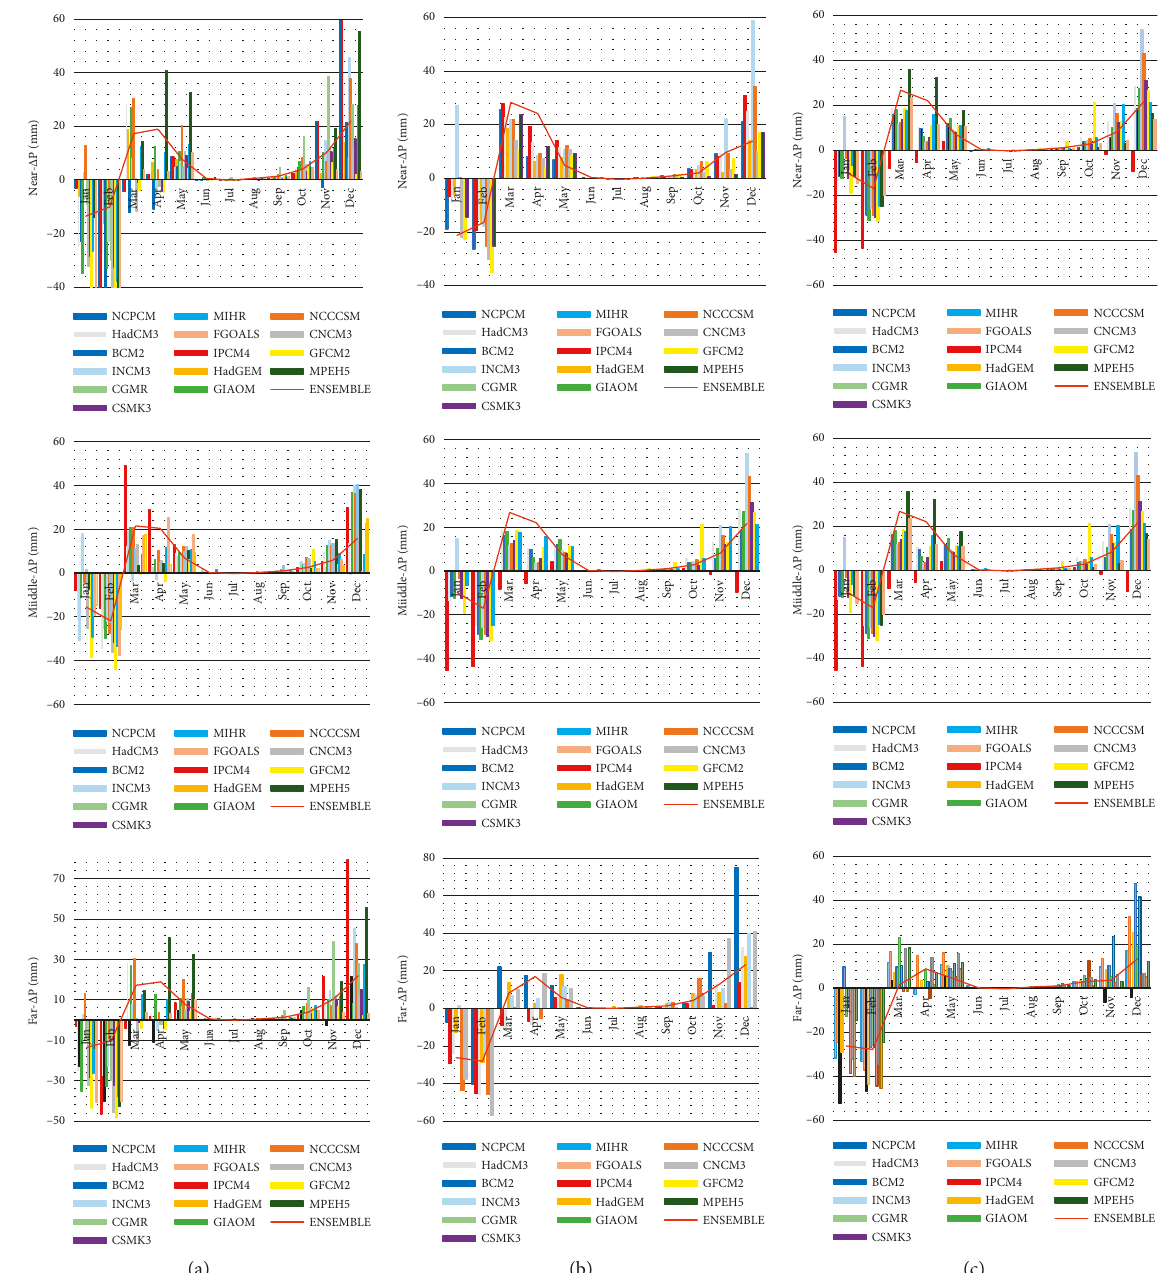
Figure 4: Monthly rainfall changes under different GCMS, ensemble approach versus observational values in the tree future period for the three future period under scenarios (a) A1B, (b) A2, and (c)